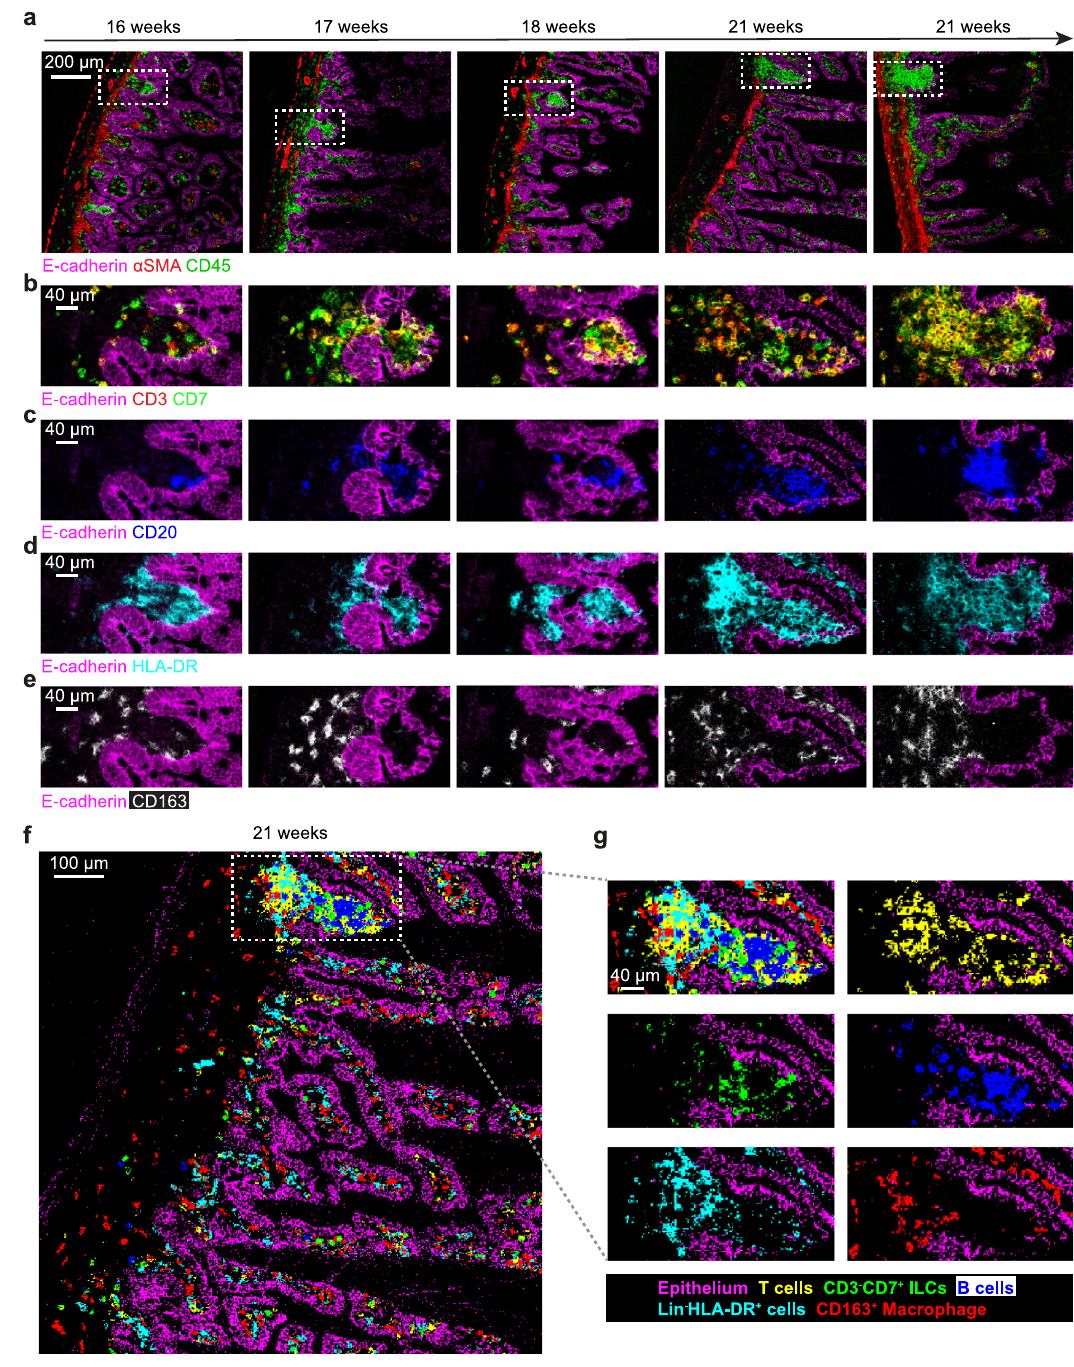
Fig.5|Identi fi cationandvisualizationoftheimmunecellcompositionofLFsin humanfetalintestinalsamplesbyimagingmasscytometry.a VisualizationofE- cadherin, α SMA, and the immune cellmarker CD45reveals the overallstructureof the fetal intestinal samples from week 16 through 21 and the location of LF (indi- cated by boxes) within those samples. Scale bar, 200 μ m. Identi fi cation of CD3 + CD7 + T cells (yellow) and CD3 – CD7 + ILCs (green) by the overlay of CD3 (red)